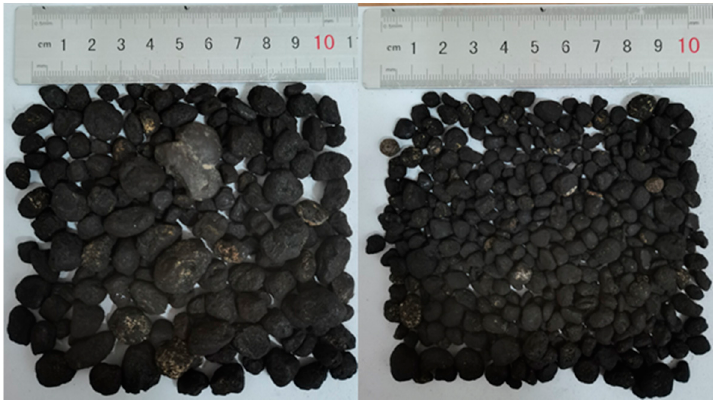
Figure 13. PSD of polymetallic nodules in the original ( left ) and after running for 10 min (54 impacts) in the experimental system ( right ).